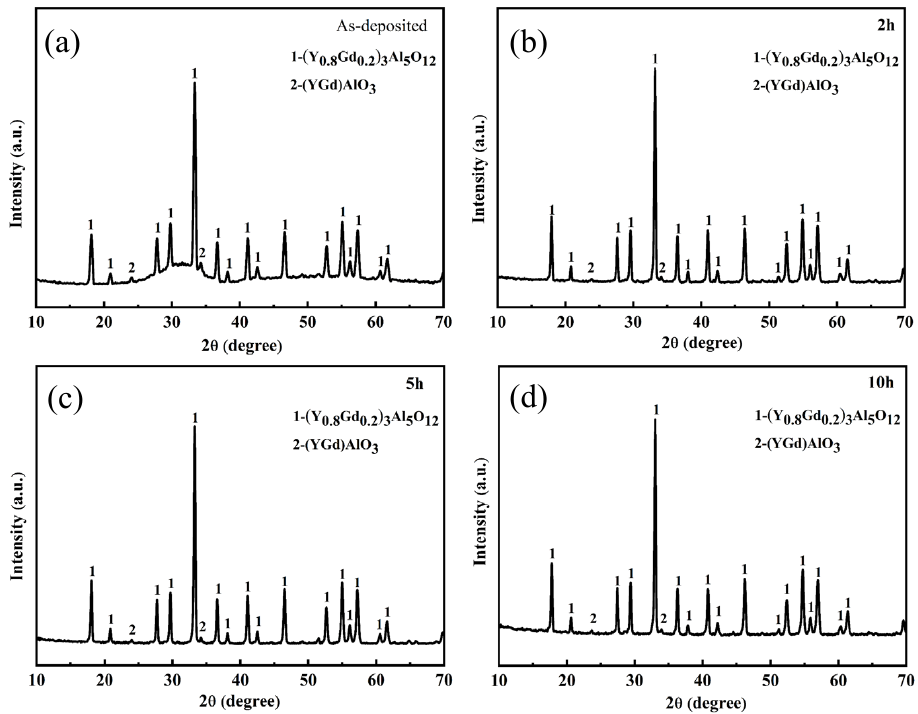
Figure 11. XRD patterns of the GYAG coating heat treated at 1100 °C for different times: ( a ) as- deposited; ( b ) 2 h; ( c ) 5 h; ( d ) 10 h.